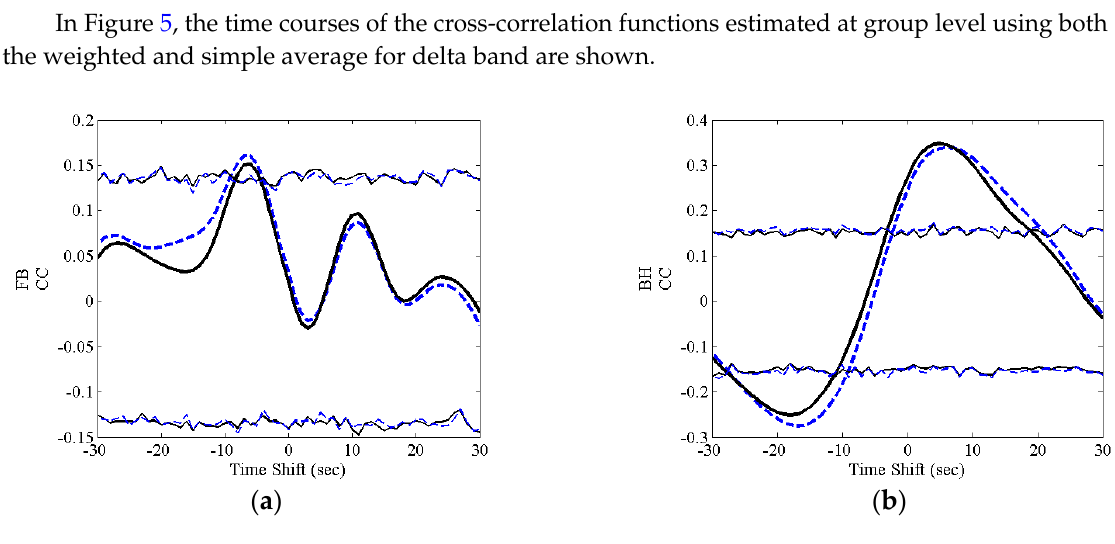
Figure 5. Time courses of the cross-correlation functions as a function of the time shift. Dashed blue lines represent the simple average while the solid black line is the weighted average. The thin lines represent the level of significance for simple average (thin dashed blue line) and weighted average (thin solid line). ( a ) FB related results; ( b ) BH results.